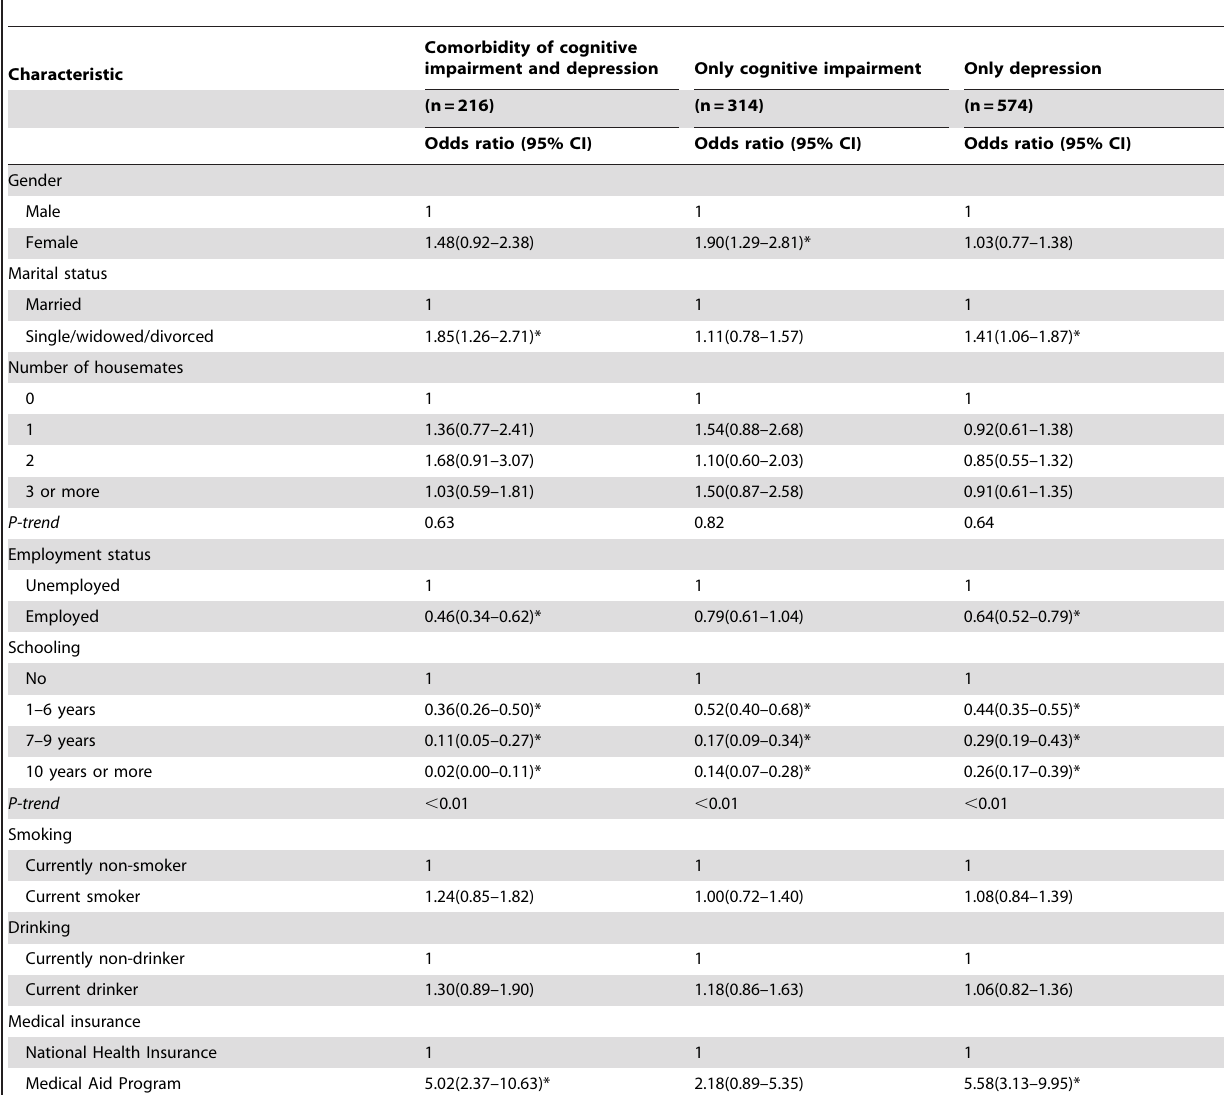
Table 4. Multivariate multinomial logistic regression analysis between socio-demographic variables and comorbidity of cognitive impairment and depression in adults aged 60–64 living in a rural area,